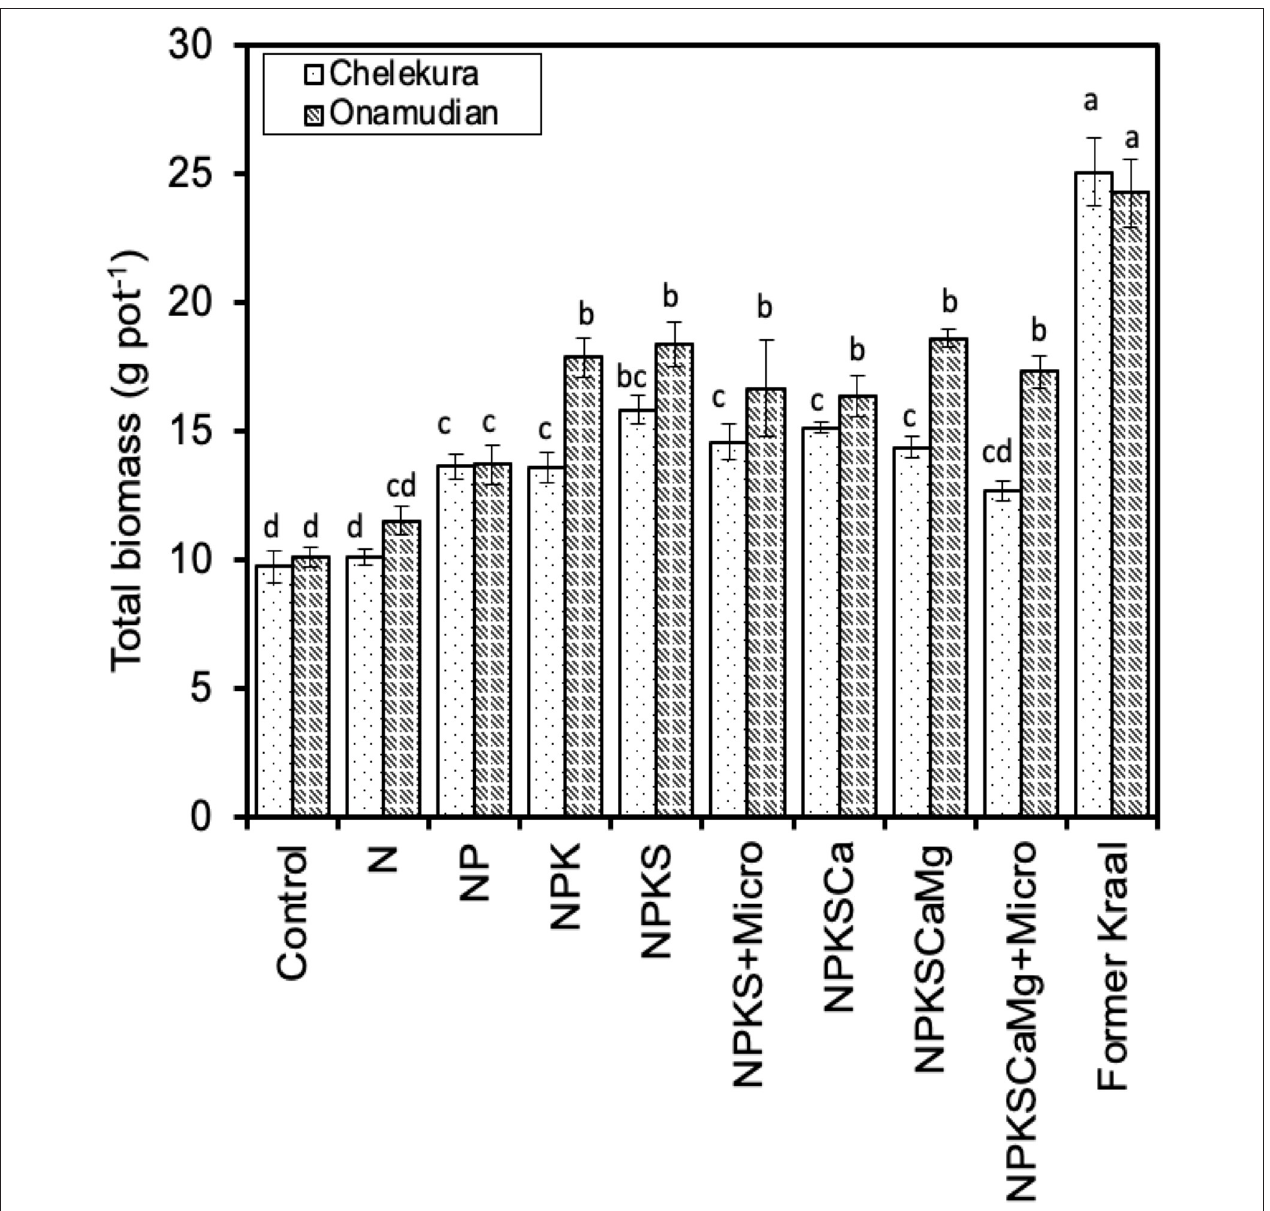
FIGURE 5 | Response of millet total biomass on soils from degraded fields from study villages amended with macro- and micronutrients and on former kraal soils in a greenhouse pot experiment over 8 weeks of growth. Bars are SEM. SE bars with same letters are not